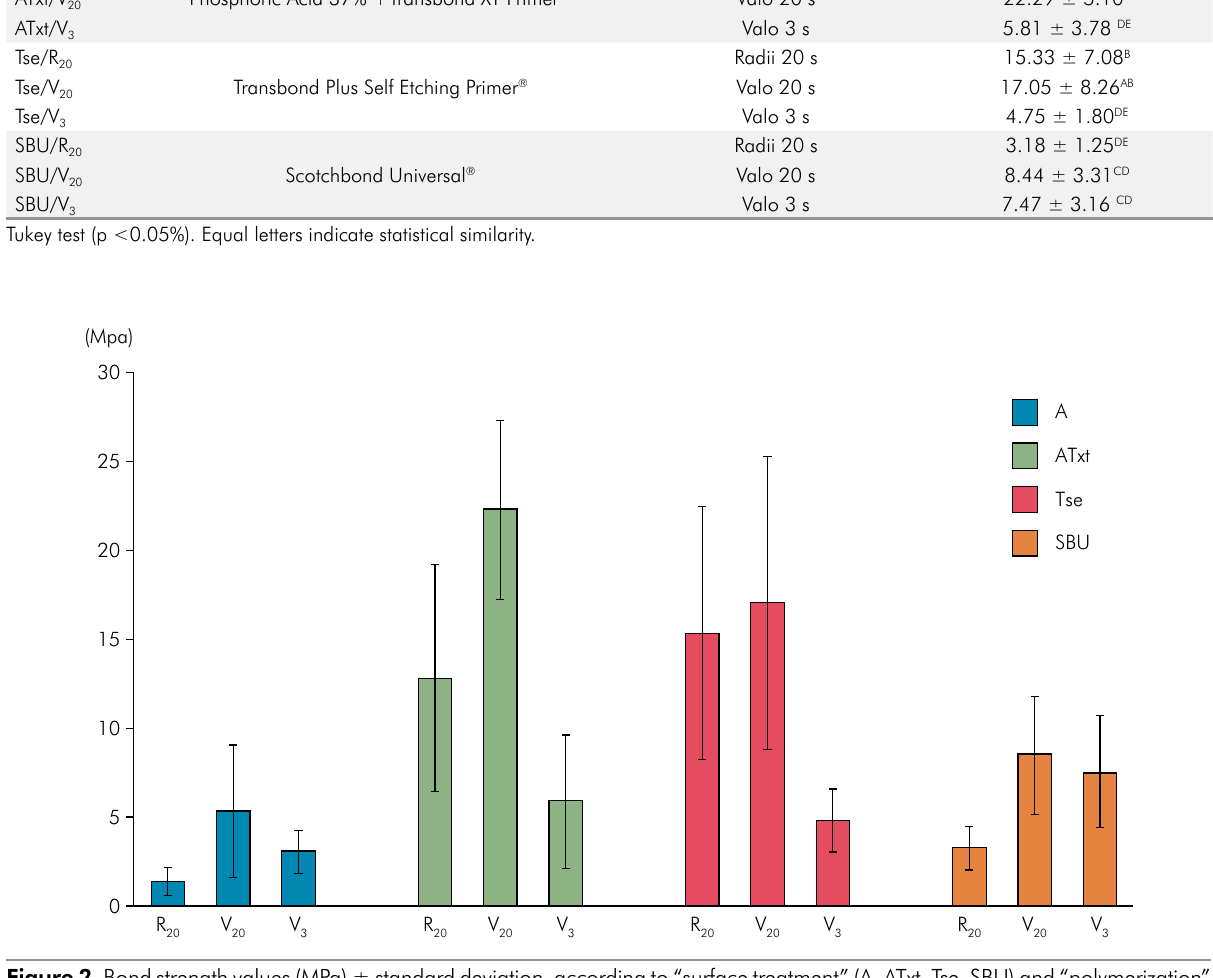
Figure 2. Bond strength values (MPa) ± standard deviation, according to “surface treatment” (A, ATxt, Tse, SBU) and “polymerization” (R , V , V ) 20 20 3